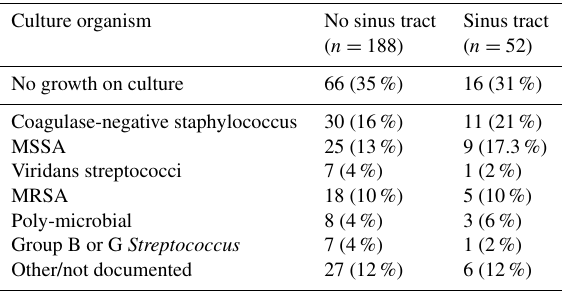
Table 3. Microbial culture data. No organism was identified in the majority of both the sinus tract and non-sinus tract